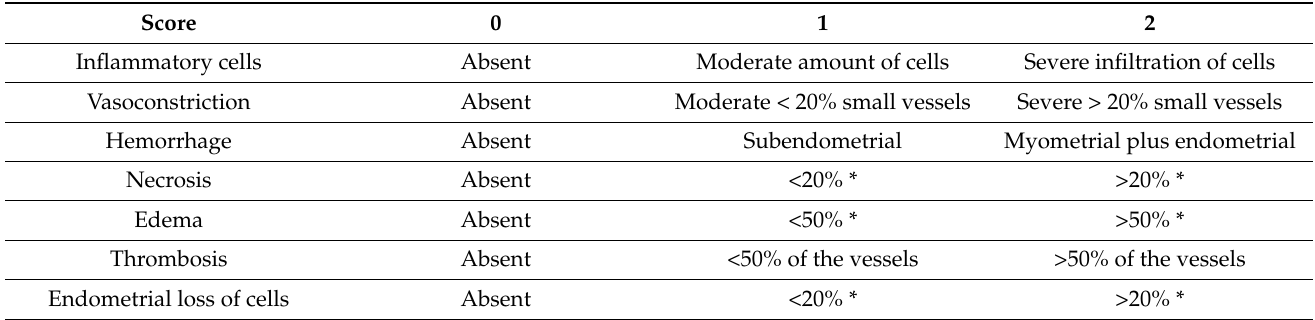
Table 1. Light microscopy morphological scoring system for evaluation of the uterus IRI